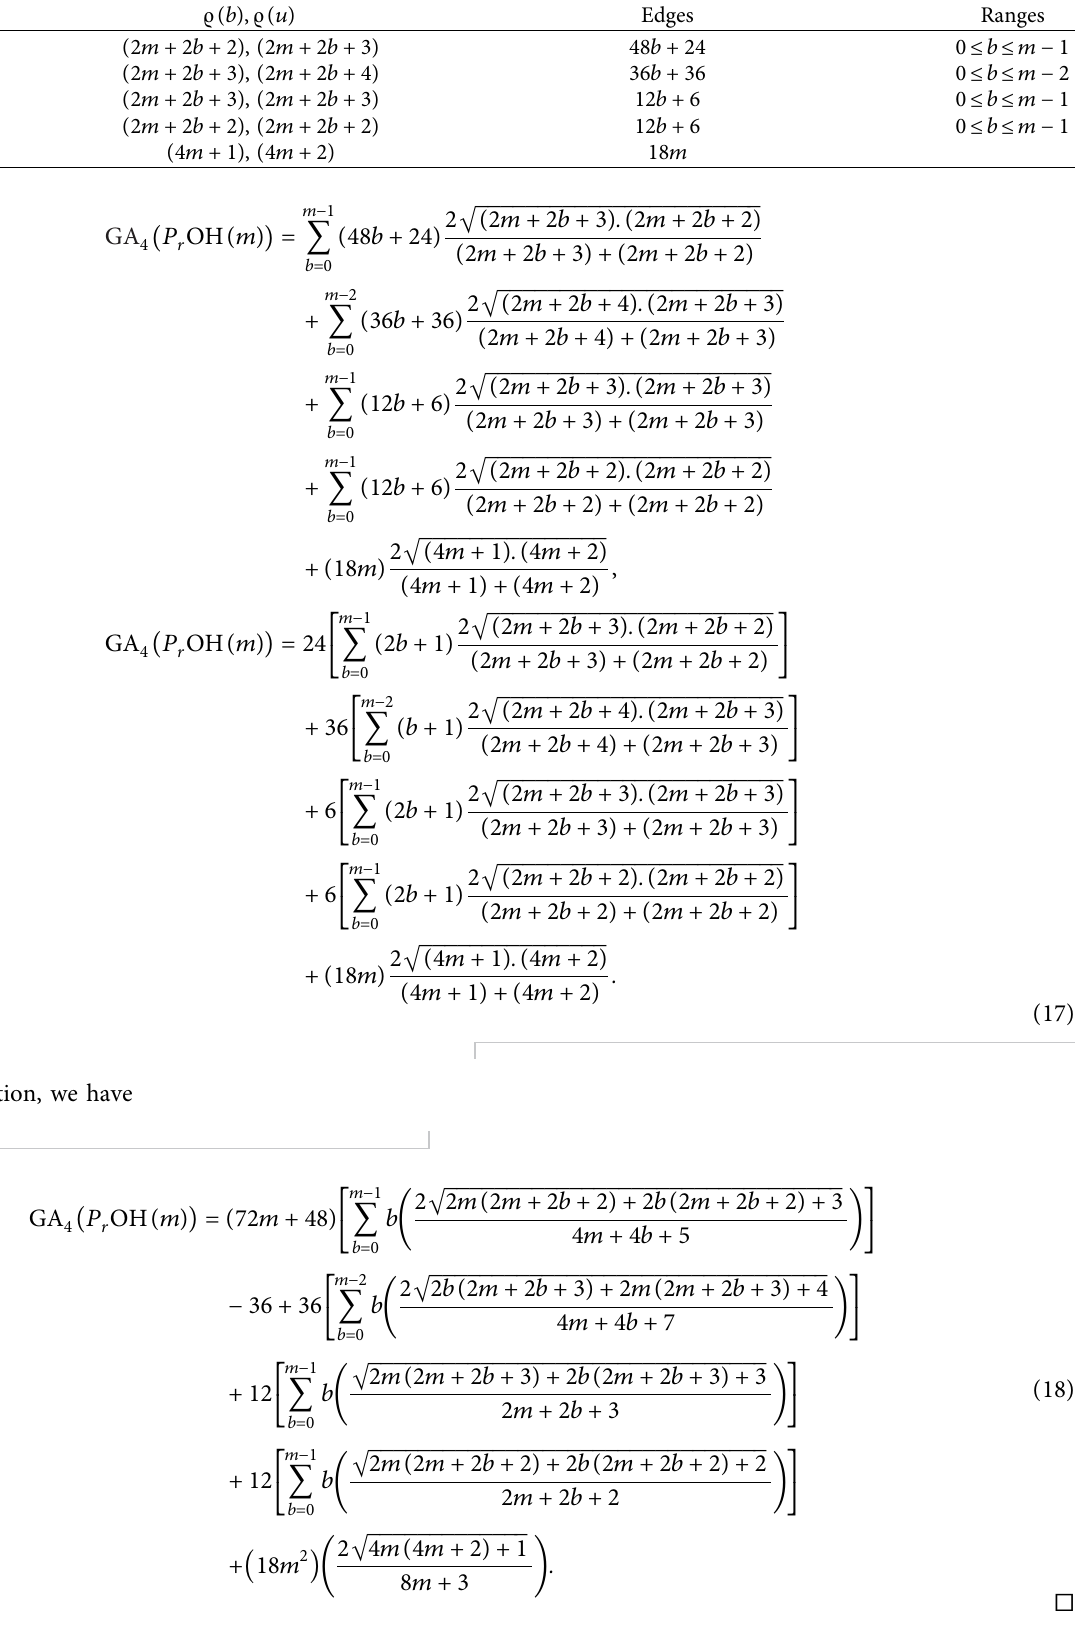
Table 2: Edge partition of P